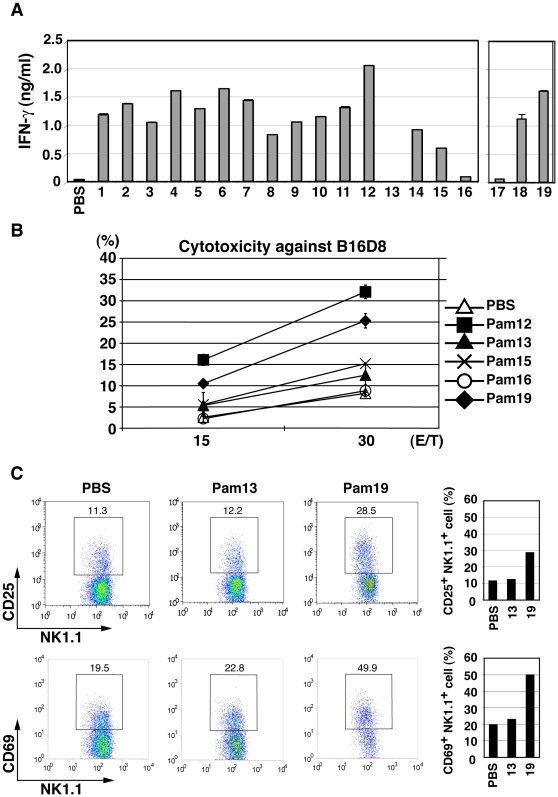
Pam2Cys peptides activate NK cells via BMDC.(A) Wild-type BMDC and wild-type NK cells were co-cultured at 1∶2 ratio in the presence of Pam2Cys peptides as the numbers indicated (100 nM). After 24 h, IFN-γ concentrations in the supernatants were measured by ELISA. (B) NK cell cytotoxicity against B16D8 cells was measured by 51Cr release assay at indicated E∶T ratios as described in the Methods section. (C) Populations of CD25+ and CD69+ NK cells were measured by flow cytometry after stimulation of NK cells with BMDC treated with indicated Pam2Cys peptides. BMDC were stimulated with control PBS, 100 nM of Pam2Cys13 or Pam2Cys19 for 4 h. Then, BMDC were incubated with NK cells. After 24 h, cells were analyzed by flow cytometer using the markers for separation. %Positive cells are shown to the right.